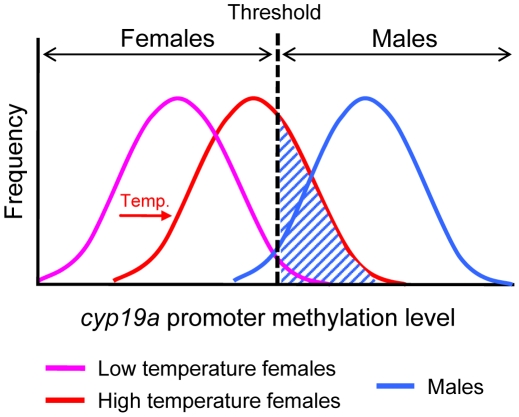
Schematic diagram of the frequency distribution of the sb cyp19a promoter methylation levels in females and males.Low methylation levels (purple curve) of the sb cyp19a promoter are typical of females and are required for ovarian differentiation. Males typically show high methylation levels (blue curve) of the cyp19a promoter. This blocks aromatase transcription and induces testicular differentiation caused by lack of estrogens. As shown in this study, high temperatures (HT) during the thermosensitive period increase methylation levels of the sb cyp19a promoter (red curve), shifting the female distribution closer to that of males. The dashed area represents the fraction of genotypic females that are sex reversed into phenotypic males by high temperature.